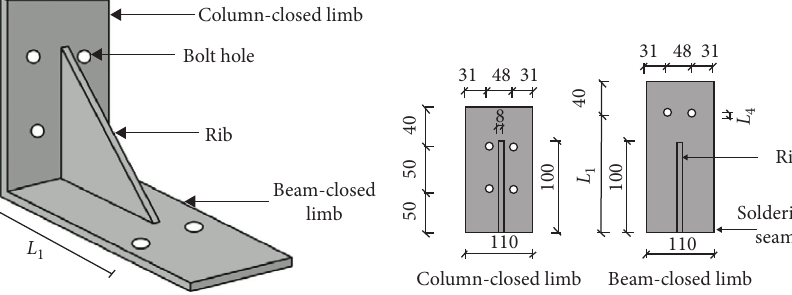
Figure 3: Cross section of the angle steel (units: mm).